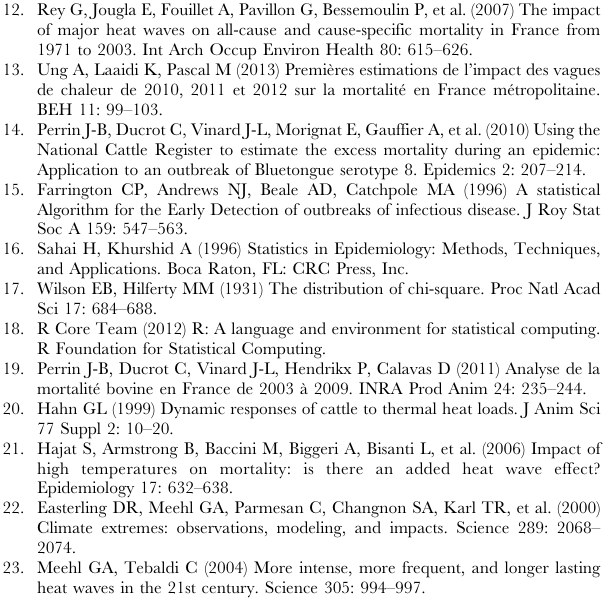
Figure S1 Number of days with maximal temperatures above 35 u C during the summer heat waves of 2003 (August 2 to 14) and 2006 (July 10 to 28) in France. These maps were obtained from the French national meteorological